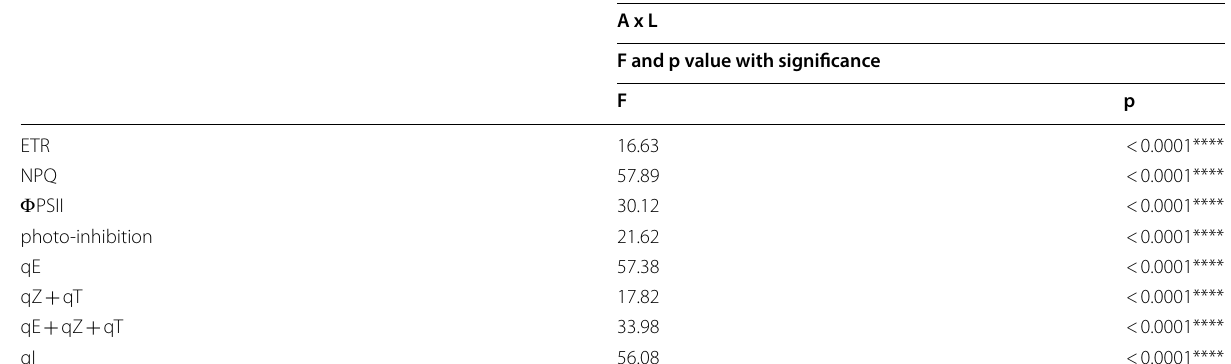
L) on ETR, NPQ, Ф PSII, photo‑ ×